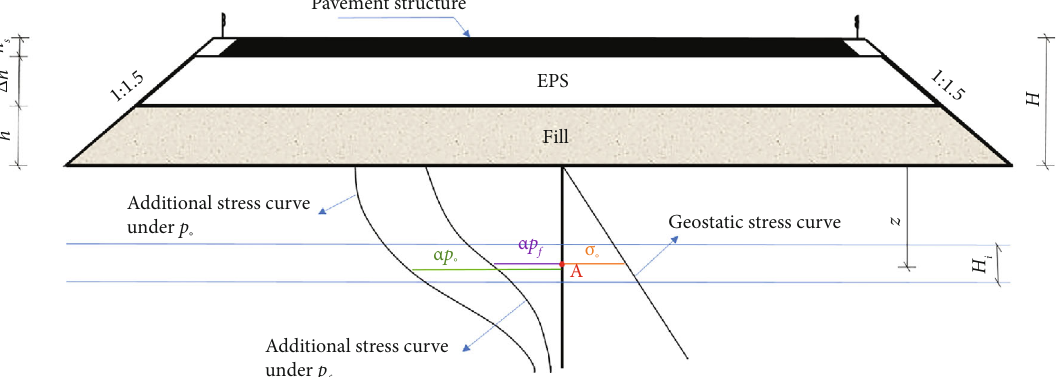
Figure 4: Cross-section of EPS fi lling.